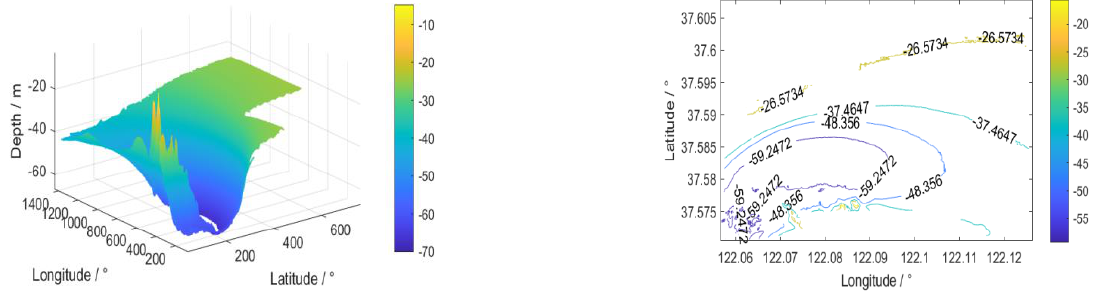
Figure 3. Two-dimensional and three-dimensional isobath graphs of the sea area.